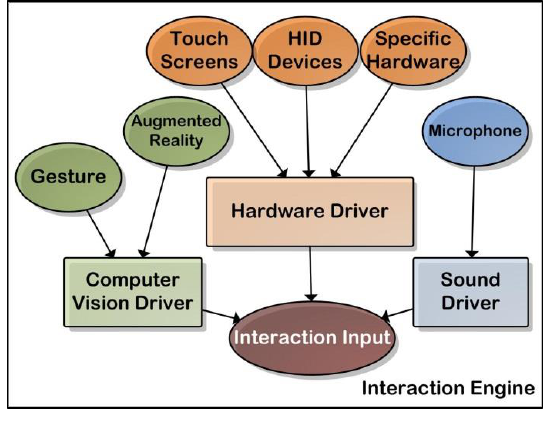
Fig. 14. The Interaction Engine and its drivers.